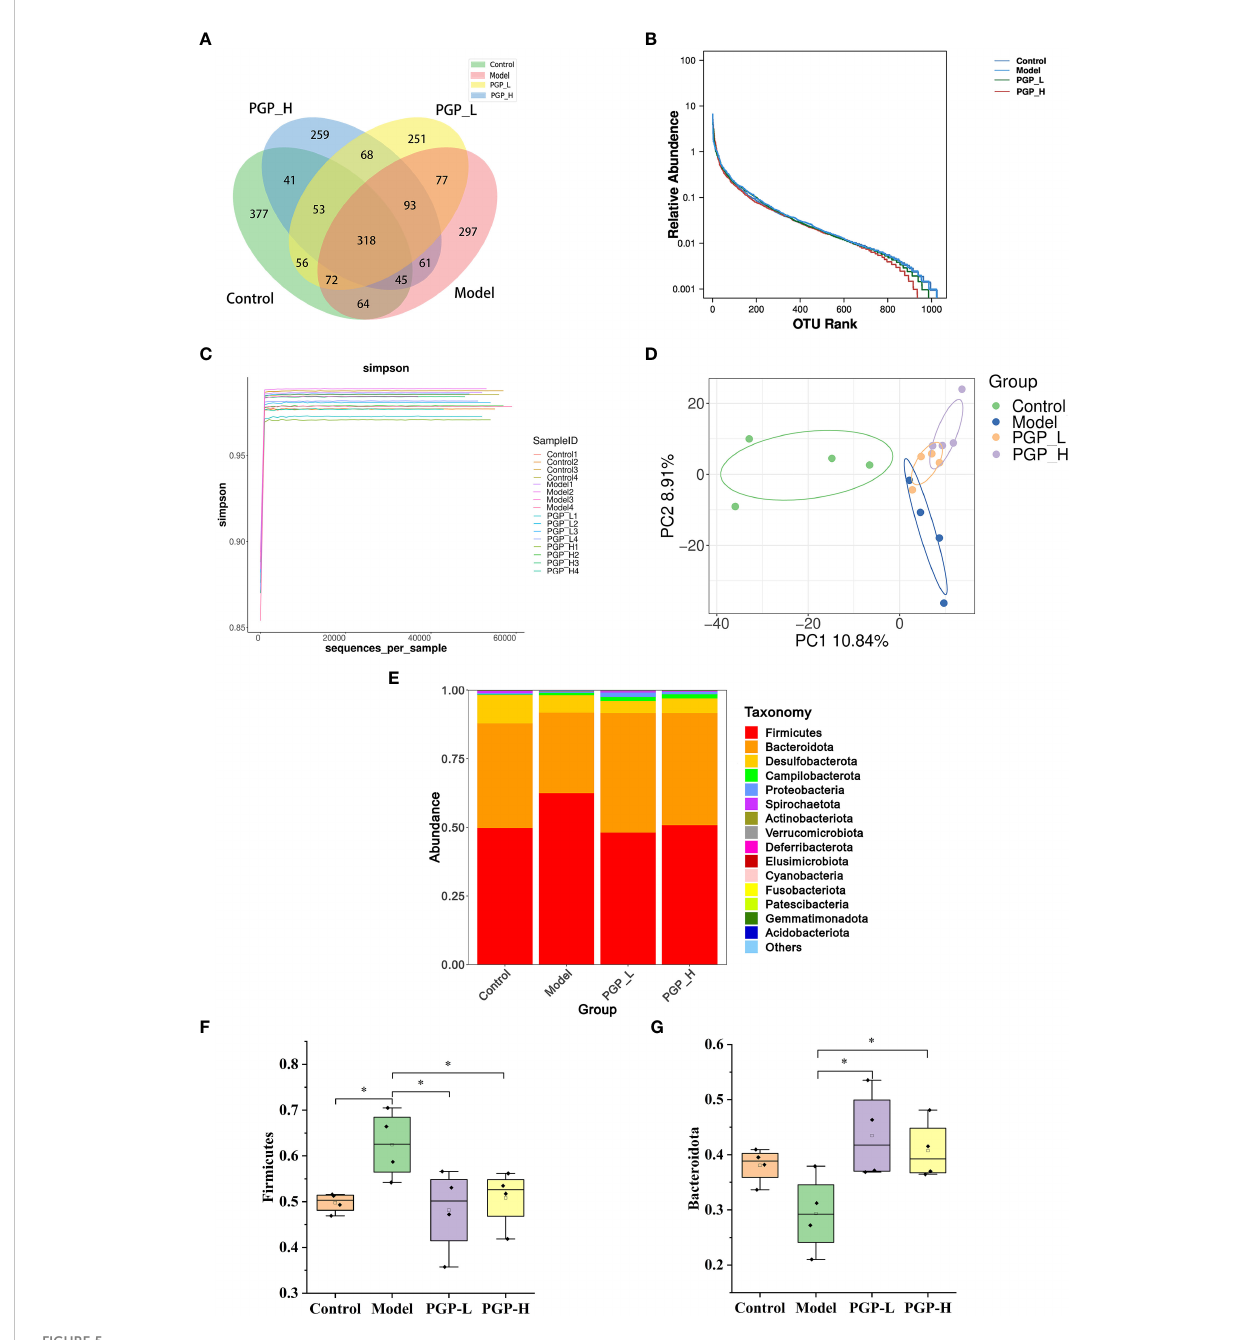
FIGURE 5 Regulation of the intestinal microbiota by PGP on in rats with constipation. (A) Venn diagram of the number of common and operational taxonomic units (OTUs) in the fl ora in the cecum of rats; (B) rank-abundance curve; (C) amplicon sequence variant/diversity index dilution curve; (D) principal co-ordinate analysis of gut microbiomes; (E) cumulative histogram of species at the phylum level. Relative abundance of (F) Firmicutes and (G) Bacteroidetes. * p <